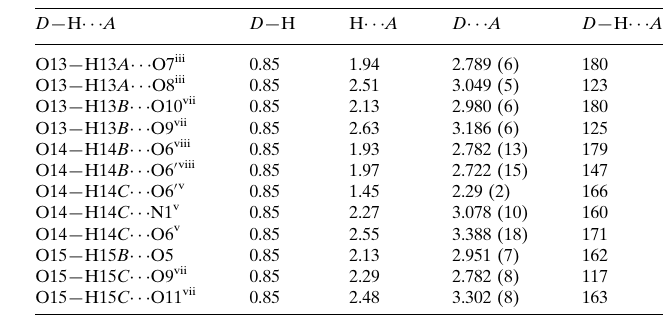
Hydrogen-bond geometry (A ˚ , (cid:3)